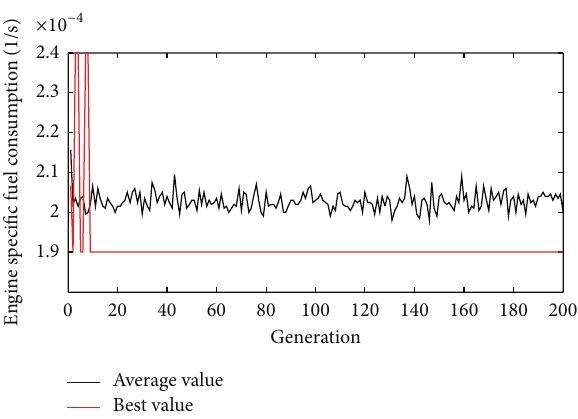
Figure 9: Best and average engine specific fuel consumption (1/s) versus